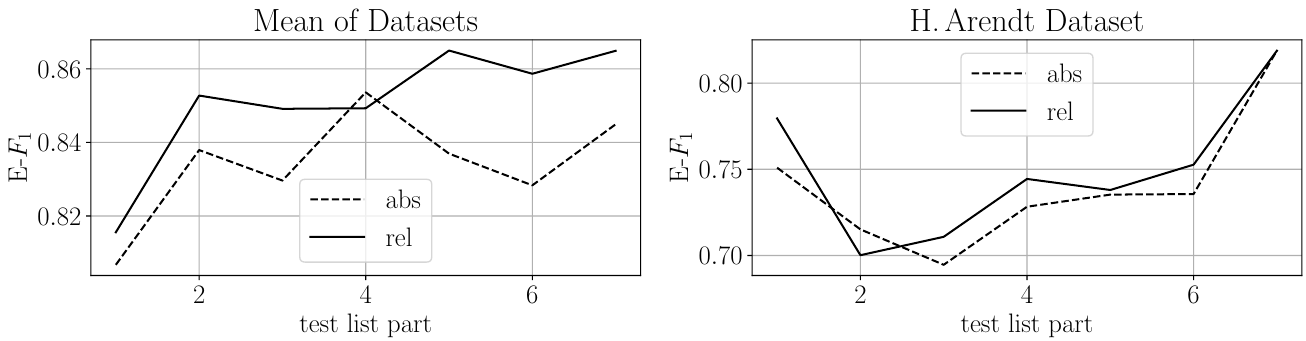
Figure 3. The E- F 1 score for a BERT trained on Mask Language Model (MLM) task with Whole-Word Masking (WWM) for relative and absolute positional encoding fine-tuned with Default-Fine-Tuning (see Section 4) tested on seven parts of the test list, which are sorted by token length, starting with short sequences. Left shows the mean over all datasets, and the right shows the results on one dataset (H.Arendt).